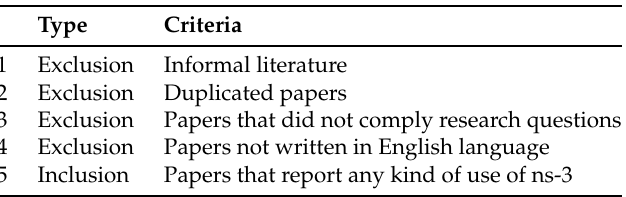
Table 6. Inclusion/exclusion